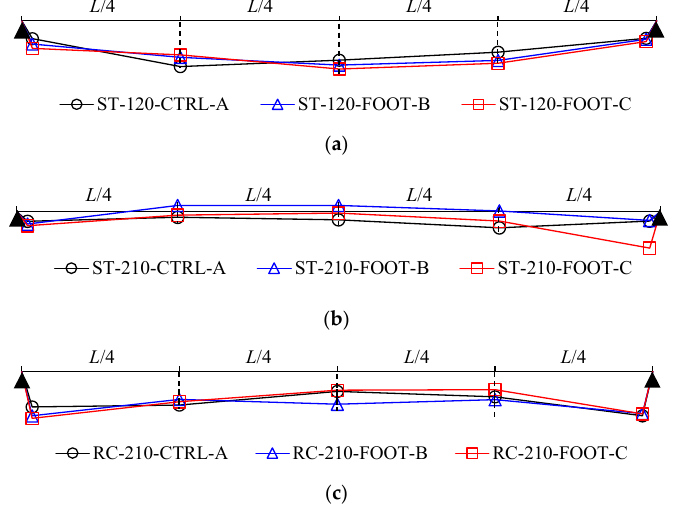
Figure 7. Deflection distributions at the final loading step. ( a ) Group-1. ( b ) Group-2. ( c ) Group-3.